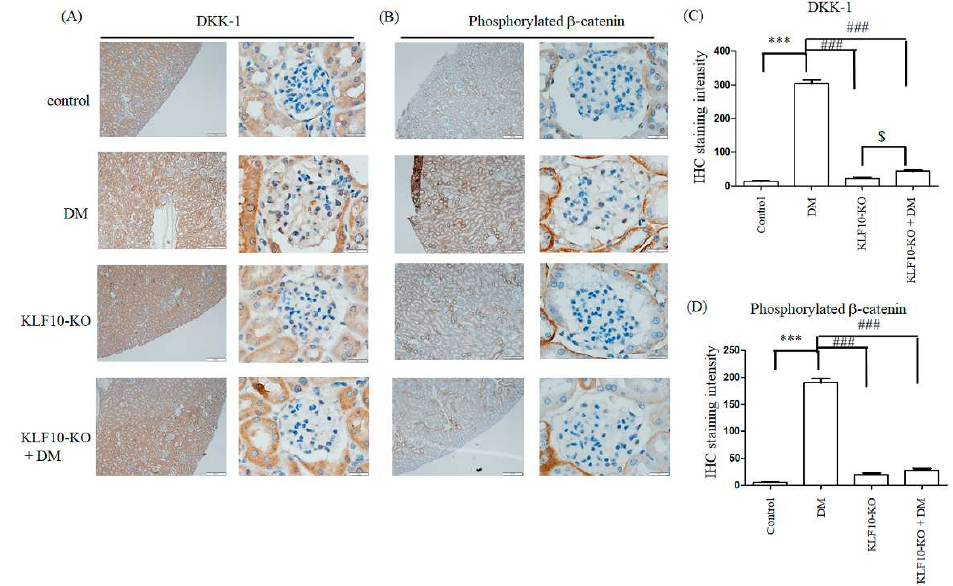
Figure 3. Knockout of KLF10 repressed DM-induced DKK-1 and phosphorylated β-catenin expres- sion . Kidney glomerular mesangium sections derived from control or KLF10 knockout mice with or without diabetes (DM) were subjected to immunostaining with the ( A ) DKK-1 and ( B ) phosphory- lated β-catenin primary antibody. Left panel: magnification of 100×, right panel: magnification of 1000×. ( C ) DKK-1 and ( D ) phosphorylated β-catenin; data are presented as means ± standard devi- ation from three different mice ***: p < 0.001 compared with the control group. ###: p < 0.001 com- pared with the DM group. $: p < 0.05 compared to KLF10-KO group. Scale bar: 200 μM at 100× and 20 μM at 1000×.